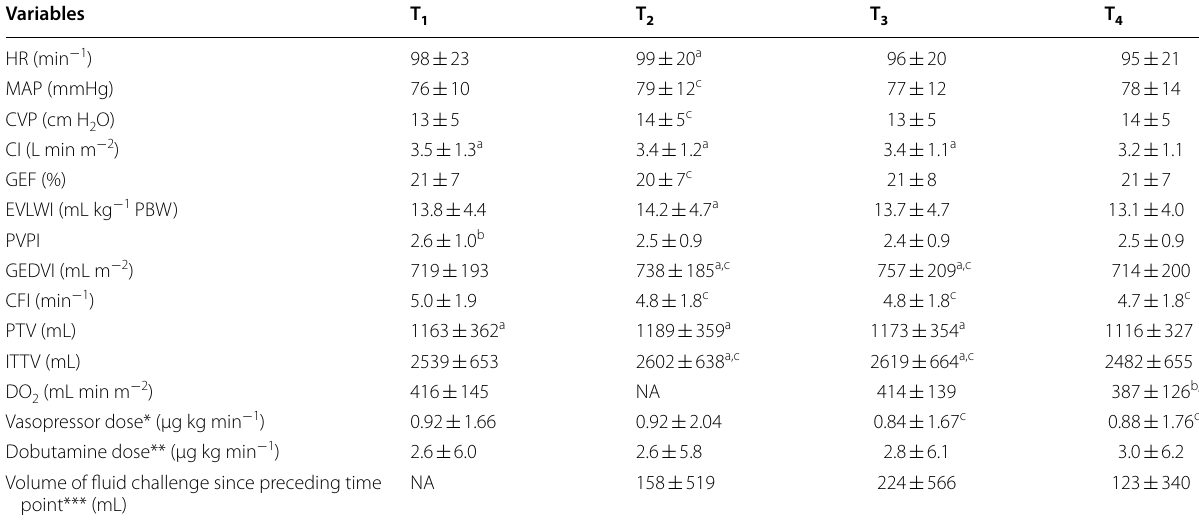
Values are mean standard deviation. All statistical tests are performed after adjustment for volume of fluid challenges since preceding time point, vasopressor and ± dobutamine dose unless specifically stated CI, cardiac index; CFI, cardiac function index; CVP, central venous pressure; DO 2 , oxygen delivery; EVLWI, extravascular lung water index; GEDVI, global end-diastolic volume index; GEF, global ejection fraction; HR, heart rate; ITTV, intrathoracic thermal volume; MAP, mean arterial pressure; NA, not available; PBW, predicted body weight; PTV, pulmonary thermal volume; PVPI, pulmonary vascular permeability index; T 1 , before prone position, T 2 , beginning of prone position session; T 3 , end of prone position session; T 4 , after prone position session